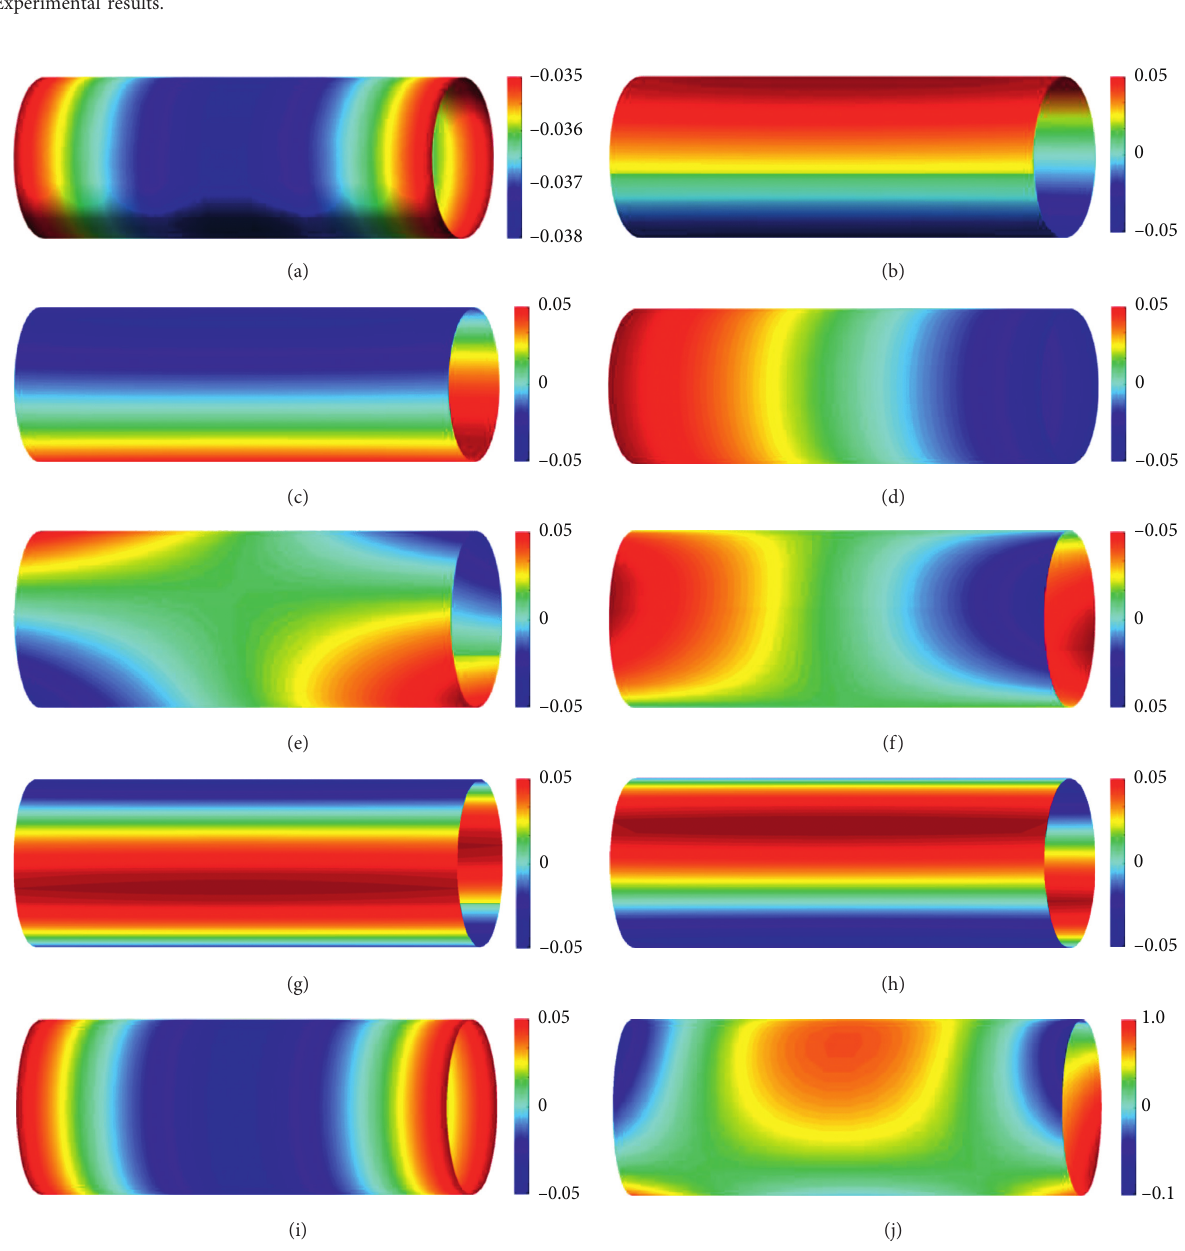
Figure 2: Modal shapes of the first ten a -modes ( kL � 1) ( a – j ) for the modes from first to tenth.